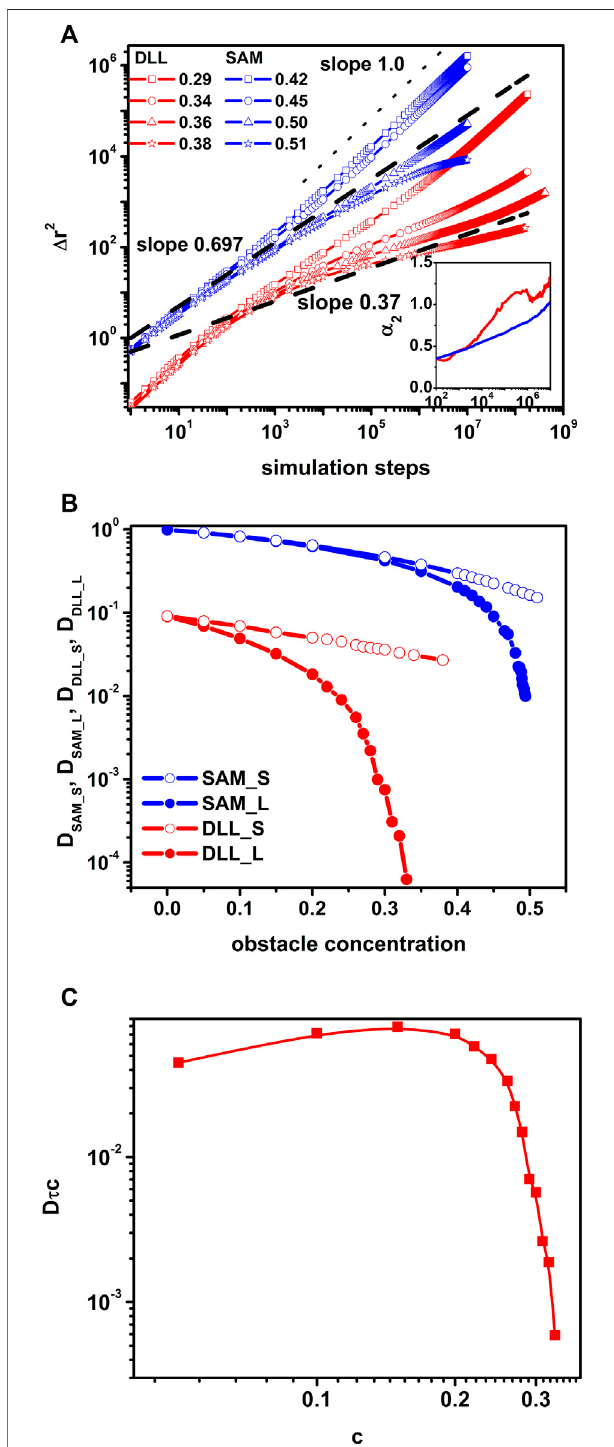
FIGURE 2 | The comparison of dynamic lattice liquid and single agent model models near the percolation point. < Δ r 2 > vs. time for concentrations of obstacles indicated in top left corner (the inset shows the non-Gaussian parametervs.timenearthepercolationthreshold) (A) ;short-time(S)and long-time(L)diffusioncoef fi cient D asfunctionsoftheobstaclesconcentration (B) ; the product D τ c as a function of the obstacles concentration (C) .